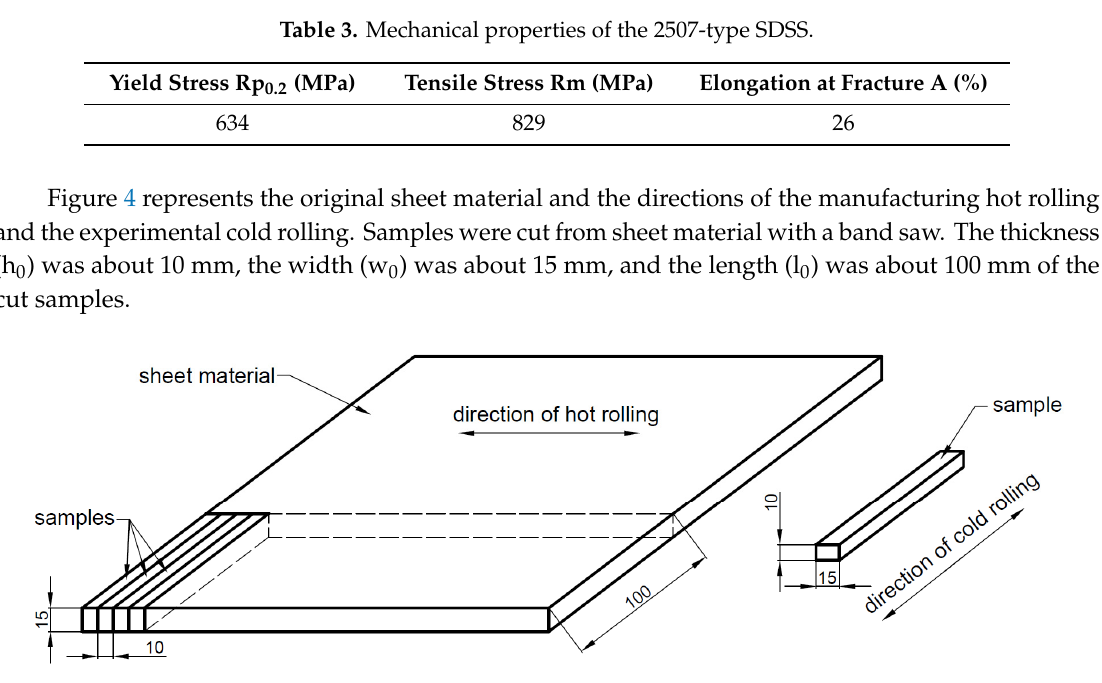
Figure 4. Directions of the manufacturing hot rolling and the experimental cold rolling.